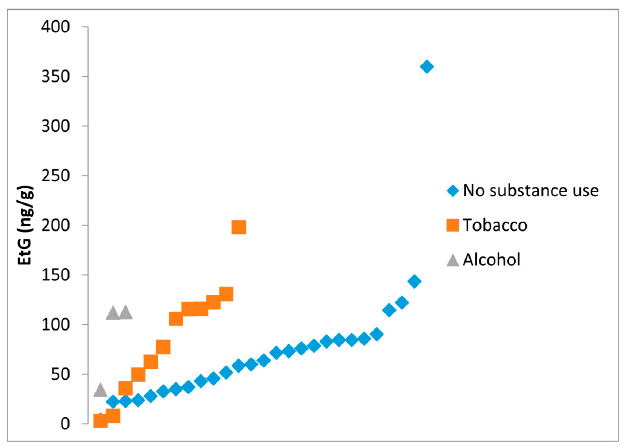
Figure 4. EtG values (ng/g) in meconium samples of newborns exposed and non-exposed to tobacco and alcohol during pregnancy.